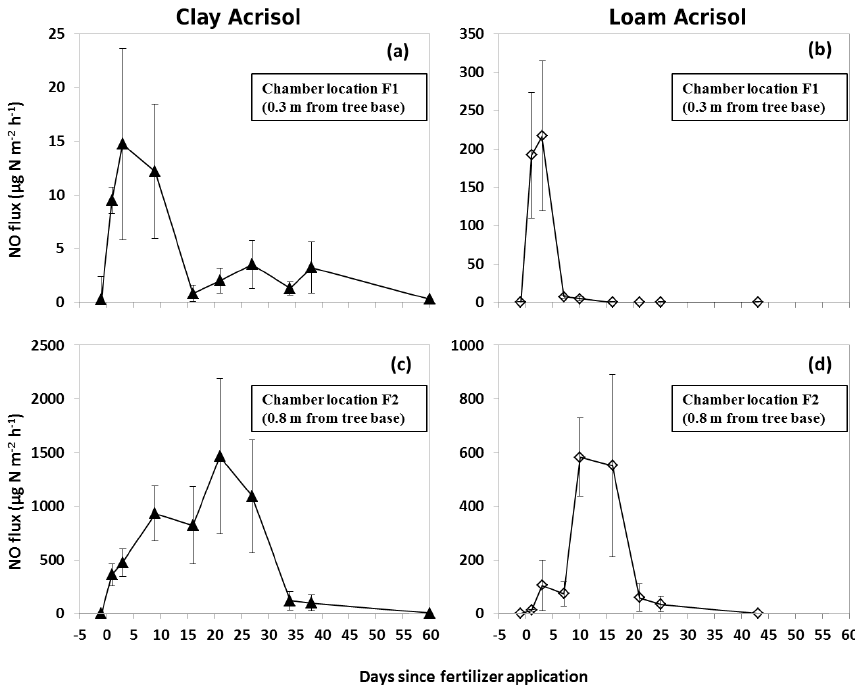
Figure 3. Mean ( ± SE, n = 3 oil palm trees) soil NO fluxes during a fertilization in a smallholder oil palm plantation in the clay (a, c) and loam Acrisol (b, d) landscapes. Smallholders fertilized around the base of each tree at about 0.8–1m from the tree base. Fluxes were measured at F1 = 0.3m from the tree base (a, b) and at F2 = 0.8m from the tree base on the fertilized location (c, d) with 0.32kgNtree − 1 in the clay Acrisol and 0.26kgNtree − 1 in the loam Acrisol in accordance to the smallholders’ practices. Table 3. Pearson correlation coefficients between soil N 2 O flux ( n = 48; µgNm − 2 h − 1 ) , soil NO flux ( n = 16; µgNm − 2 h − 1 ) , water-filled pore space (WFPS; %, top 0.05m depth), soil temperature ( ◦ C, top 0.05m depth) and extractable mineral N (mgNkg − 1 , top 0.05m depth) across landscapes for the reference and converted land uses. The correlation was conducted using the means of the four replicate plots per land use on each of the 12 monthly measurements (for soil N 2 O fluxes) and four monthly to bimonthly measurements (for soil NO fluxes). Land-use type Variable WFPS Soil temp. NH + NO − 4 3 Reference land uses (forest and jungle rubber) Soil N 2 O flux − 0.21 − 0.09 − 0.23 0.38 b Soil NO flux − 0.74 b − 0.15 − 0.48 a 0.69 b Converted land uses (rubber and oil palm) Soil N 2 O flux 0.11 0.15 0.23 0.37 b Soil NO flux − 0.05 0.09 − 0.05 0.23 a P ≤ 0 . 09 , b P ≤ 0 . 01